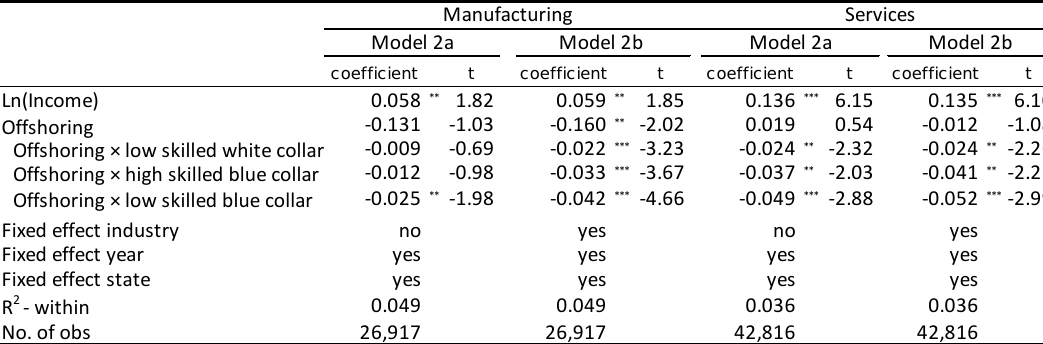
Table 5 . Job satisfaction and offshoring, by